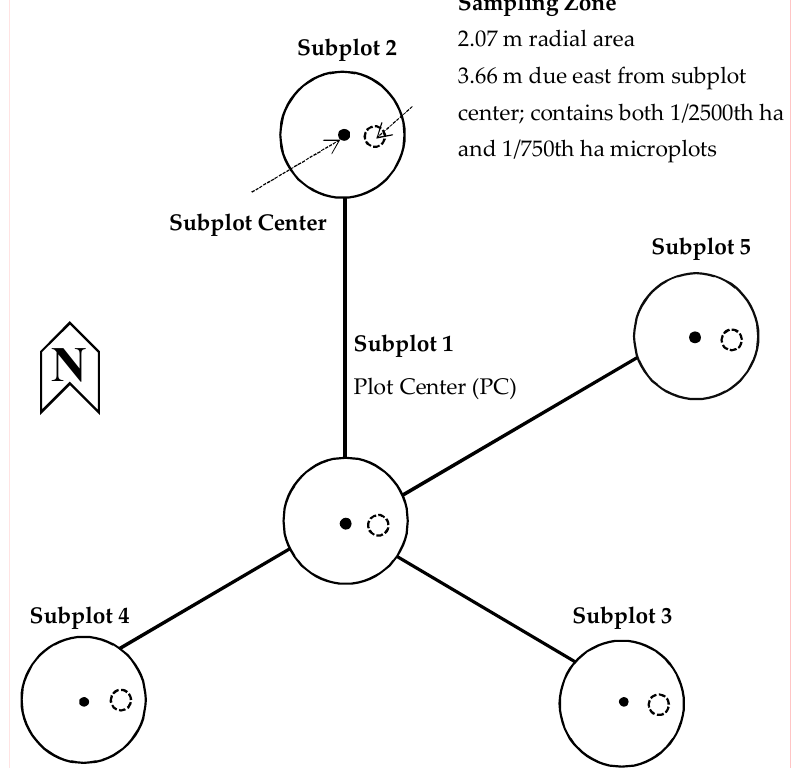
Figure 3. Configuration of subplots 1–5 at each plot location. We defined the center of subplot 1 as plot center (PC), and the area inside each subplot circle represents 1/60th ha (1/24th acre; 168 m 2 ). Sampling zone circles represent a 1/750th ha microplot (small dashed circle; 1/300th acre; 13.5 m 2 ), and nested within each sampling zone is a second 1/2500th ha microplot (1/1000th acre; 4.05 m 2 ; not